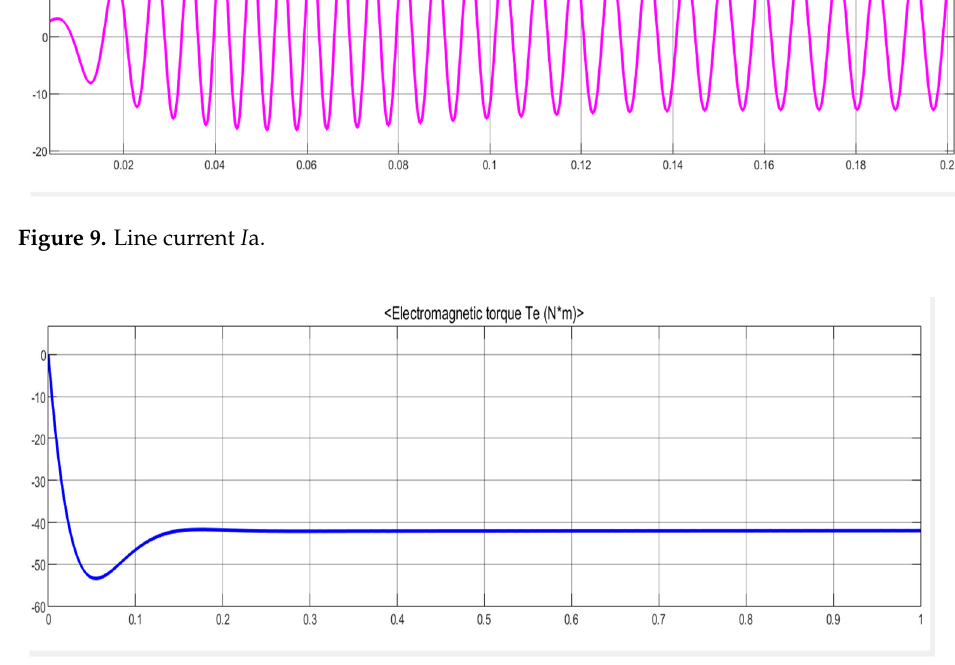
Figure 11. Speed tracking. Figure 12. Active power output of the wind generator. When setting T = 1 s in the simulation model, the active power waveform is obtained, as shown in Figure 12. From 0.02 s, the power starts to increase till 6123 W. Then, increasing T to 2, the power reaches 6120 W. When setting T = 3, the power reaches 6241 W. A comparison of results is given in Table 2 for the generator operating without an active control method, with MRAS and the proposed methods. It is shown that the PMSG using the proposed method can generate 3% more power than the conventional MRAS method, and 6% more power than that without employing an active method. A clear improvement of energy efficency is demonstrated in this study. Table 2. Comparison of the output power using different control methods. Types of Control Methods